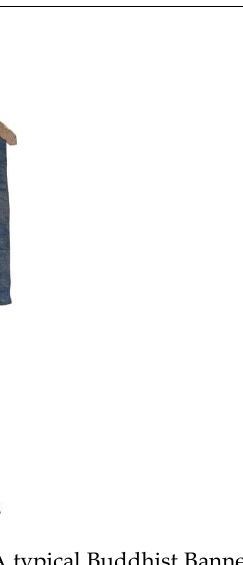
13 of 25 Figure 7. Daoist “ Spirit-Moving Banner ” (middle part), Golden Book of Salvation According to the Nu- minous Treasure Tradition (Lingbao lingjiao jidu jinshu ), DZ 466, Daozang 8:577c. A typical Daoist banner has a triangular head on the top and a rectangular body with two side streamers (arms) and another two on the bottom (legs). It is well known that the Buddhist counterpart has similar anthropomorphic names for each corresponding part (Yim 1991, p. 73; Wang 2007, p. 58) (Figure 8). The current version of the reconstructed long banner does not have a triangular head. However, it is not rare to observe a case of a long banner with a triangular head: For instance, a long banner with a similar width (68.10 cm) from the Stein Collection retains the original triangle head (Figure 9). 20 None of the extant long banners have the arms (the side streamers) and legs (the bottom streamers).